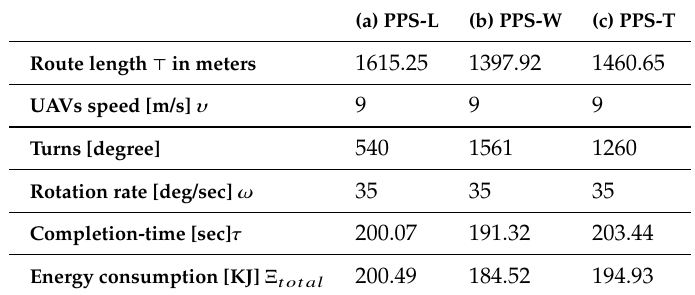
Table 10. Our CPP using our PPS-L partition method vs. PPS-W partition method vs. PPS-T partition method.